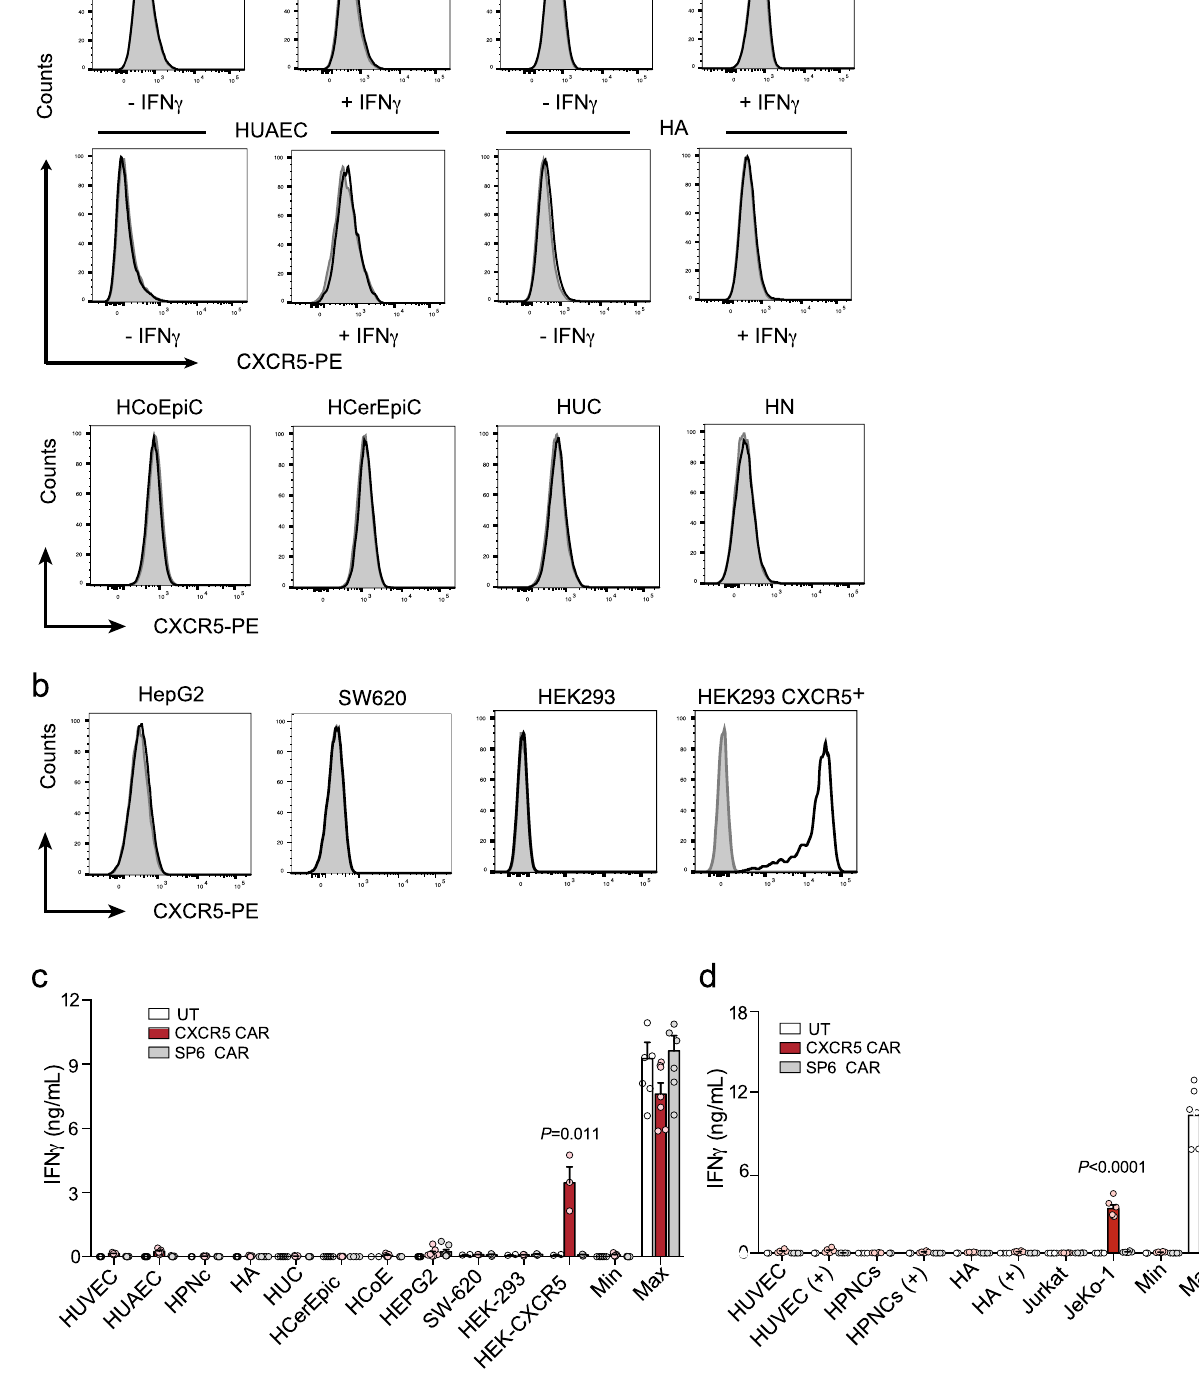
model allows us to study anti-lymphoma activity in an organized lymphoid microenvironment including B and T cell areas and to record on-target/off-tumor toxicity. The binding moiety of the mouse CXCR5 (mCXCR5) CAR is based on the rat anti-mouse CXCR5 mAb (2G8), reactive against the N-terminal domain of mouse CXCR5 (Supplementary Fig. 13a) 20 . We designed the anti-mouse CXCR5 CAR (referred to as mCXCR5 CAR) similar to the anti-